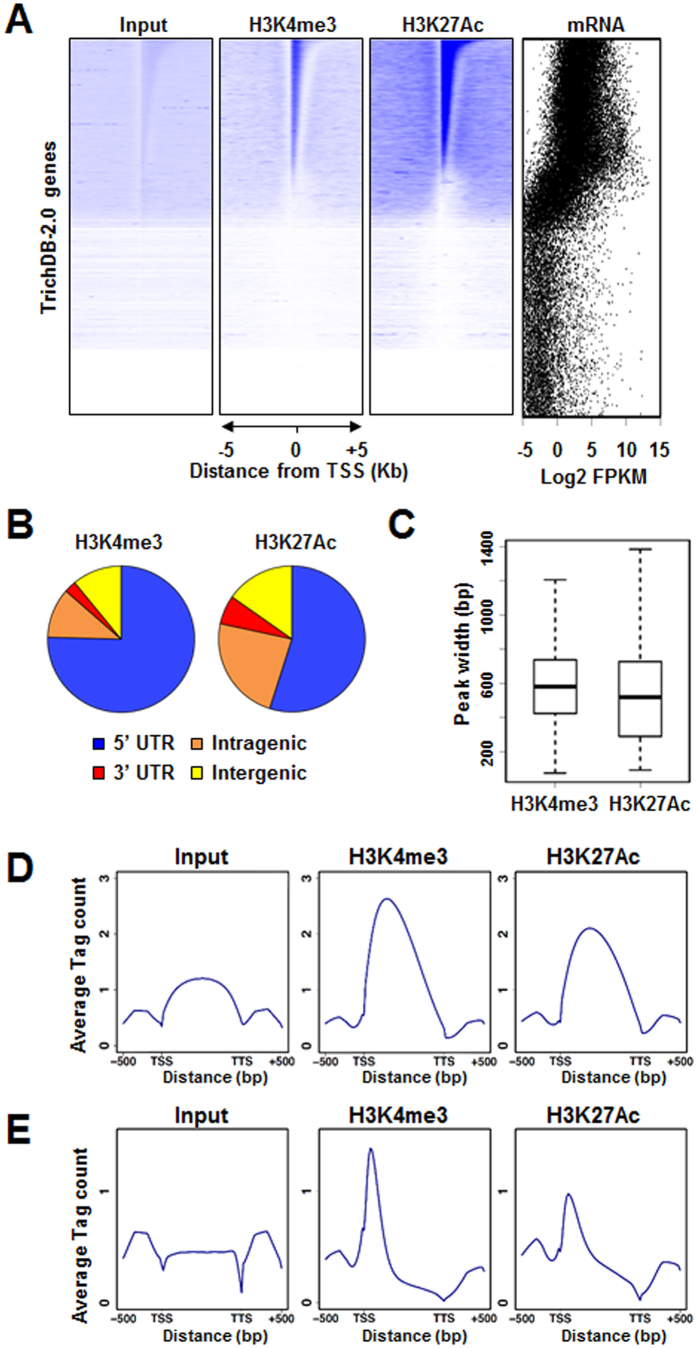
Genome-wide mapping of H3K4me3 and H3K27Ac in mock-treated T. vaginalis.(A) Density heat map shows coverages for input, H3K4me3, and H3K27Ac across 10 kb centered at the TSS of each gene, along with relative mRNA values. Individual sequences were binned in 25 bp windows (400 bins per sequence), and coverage was computed and plotted as a relative color intensity scale. In all representations, genes were ranked according to their H3K27Ac levels. (B) Pie charts present the distribution of H3K4me3 and H3K27Ac peaks among different gene features: 5′UTR, overlapping with TSS (including peaks comprising the whole gene); 3′UTR, overlapping with gene ends; intragenic, inside genes excluding the peaks that overlapped with the 5′- or 3′-ends of the gene; intergenic, upstream and downstream regions of genes. (C) Median widths of H3K4me3 and H3K27Ac peaks. (D and E) Distribution of chromatin input, H3K4me3, and H3K27Ac along gene length in all genes (D) or in relatively longer genes (gene size >2 kb) (E). TSS: transcription start site, TTS: transcription termination site.